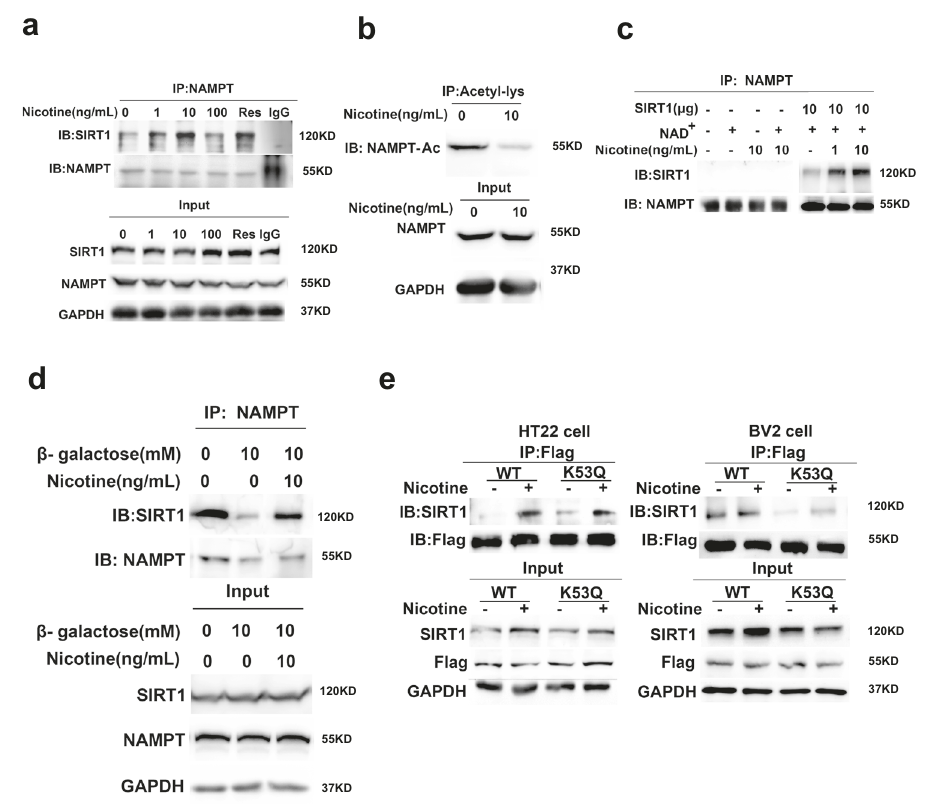
Fig. 4 | Nicotine increased SIRT1 interacts with NAMPT and deacetylation of NAMPT. a The enhancement of SIRT1 and NAMPT interaction by nicotine and resveratrol (100nmol/L). IgG antibodies were used as a negative control. b The acetylation levels of NAMPT in HT22 cells with or without nicotine for 48h. c Co- immunoprecipitation of puri fi ed protein SIRT1 with cellular NAMPT after nicotine